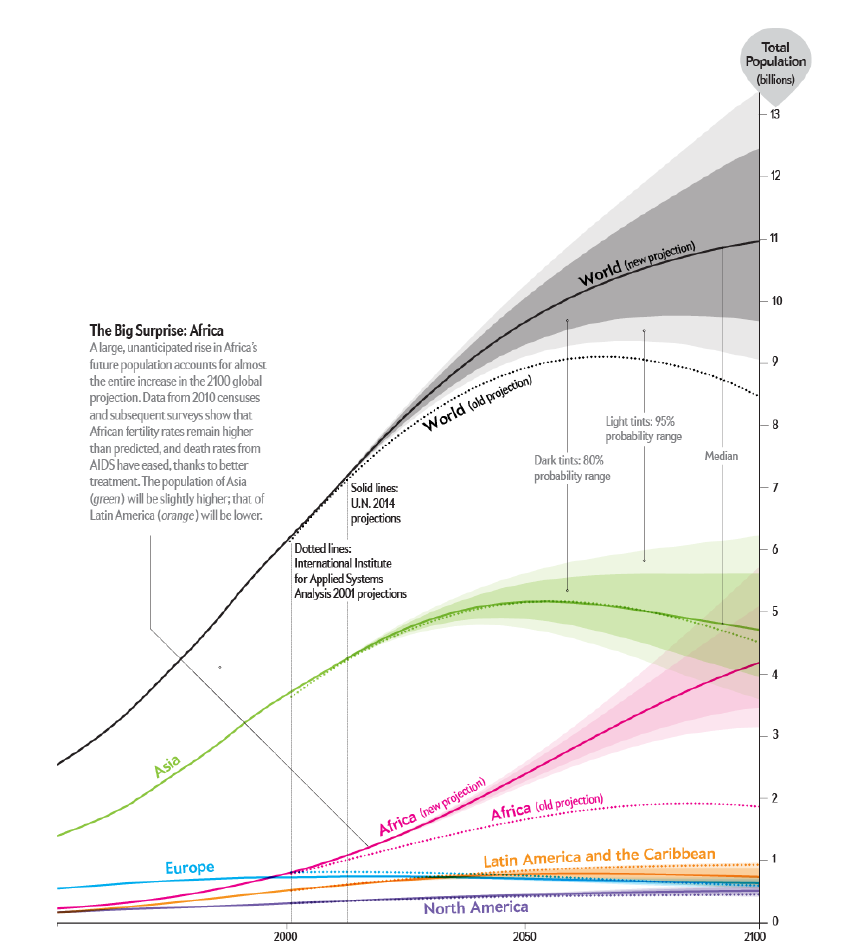
Figure 1. World Population estimated growth between the years 1950 and 2100. These charts show estimates and probabilistic projections of the total population for countries or areas, geographical aggregates and World Bank income groups as defined in Definition of Regions. The population projections are based on the probabilistic projections of total fertility and life expectancy at birth, based on estimates of the 2017 Revision of the World Population Prospects. These probabilistic projections of total fertility and life expectancy at birth were carried out with a Bayesian Hierarchical Model. The figures display the probabilistic median, and the 80 and 95 per cent prediction intervals of the probabilistic population projections, as well as the (deterministic) high and low variant (+/ − 0.5 child) of the 2017 Revision of the World Population Prospects